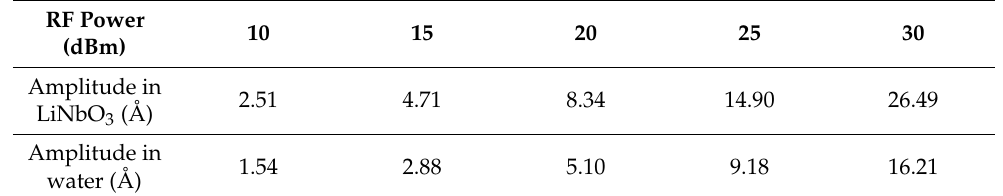
Table 1. Acoustic displacement amplitudes Â in the substrate and droplet.